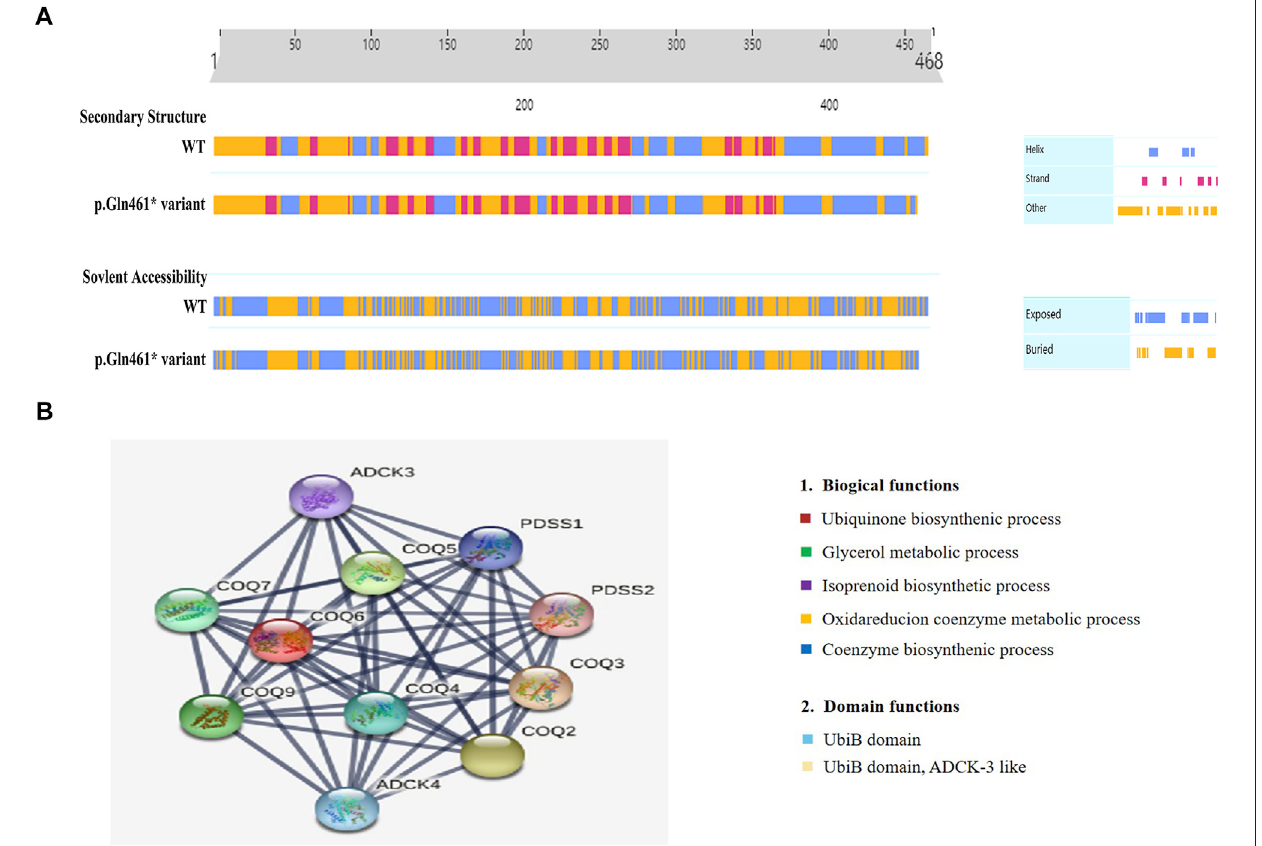
Frontiers in Genetics |